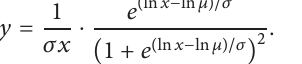
Table 4: Statistical distribution of